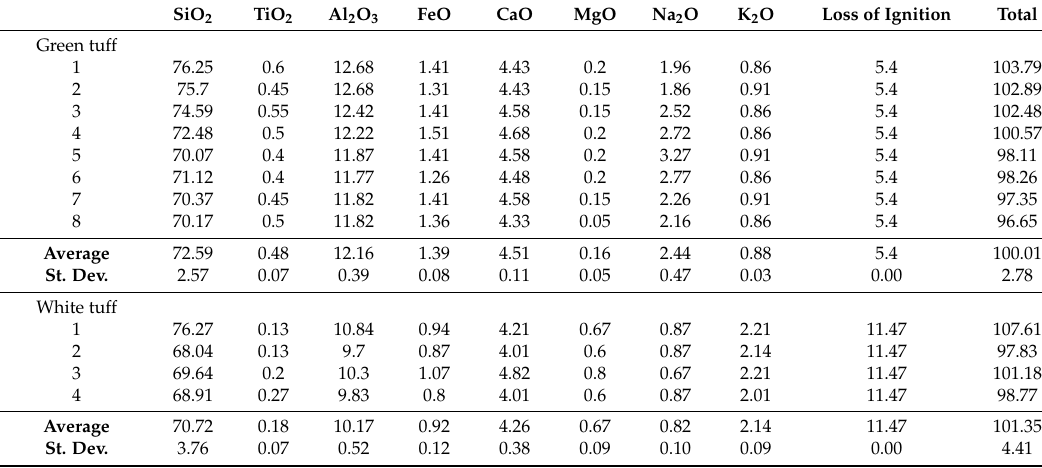
Table 1. Major element distribution for the investigated tuff